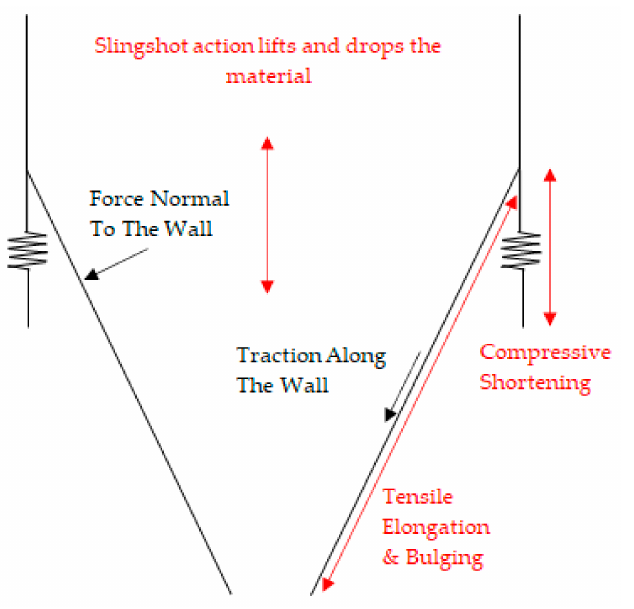
Figure 1. Slingshot